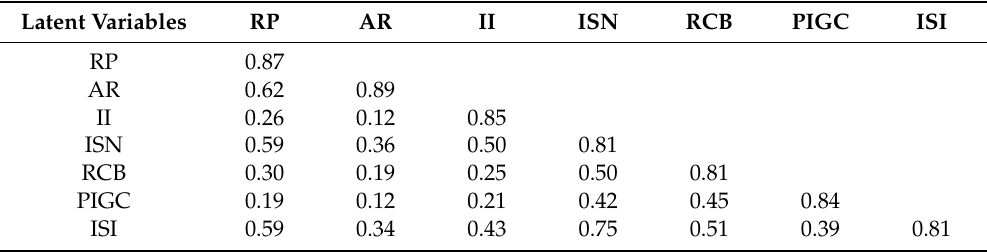
Table 4. The square root of AVE and correlation coe ffi cients of latent